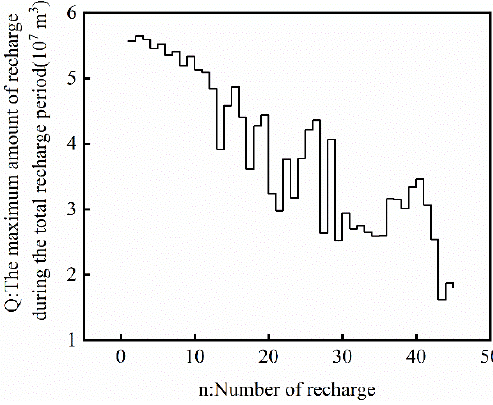
Figure 17. The maximum amount of water recharging under different recharging times.